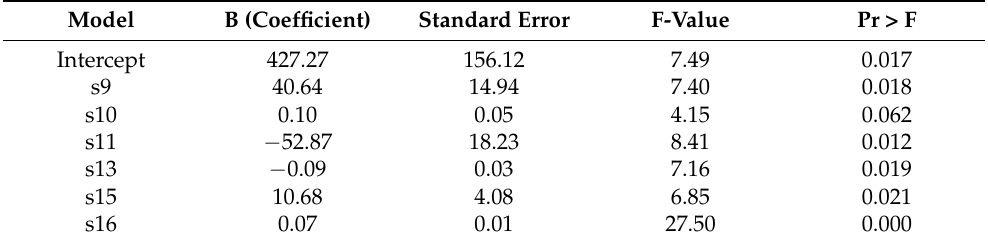
Table 5. Multiple linear regression analysis of the 100-grain weight and after anthesis meteorological